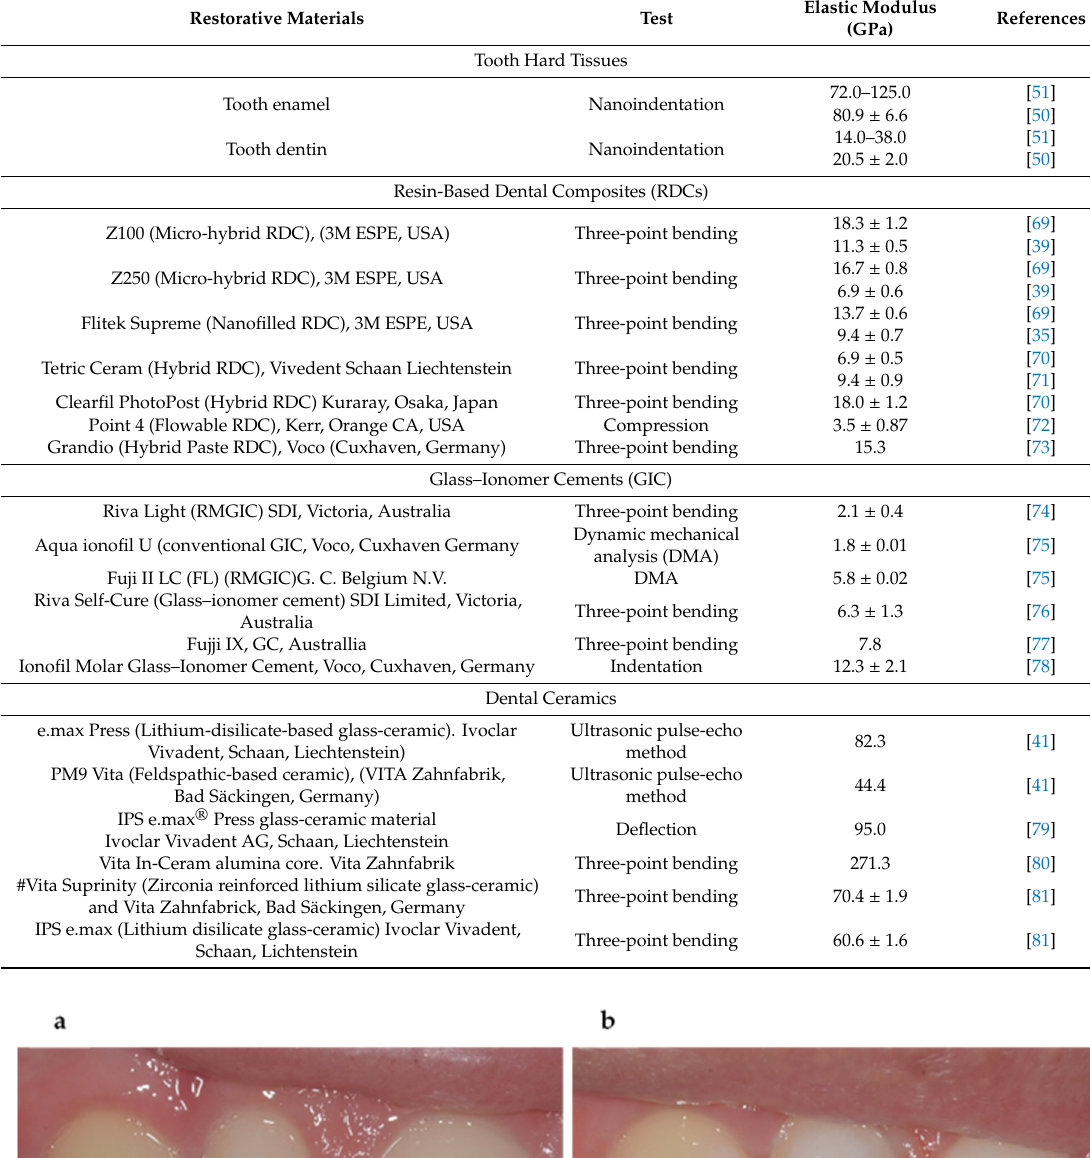
Table 3. Modulus of elasticity of tooth-colored restorative materials and tooth hard tissues.